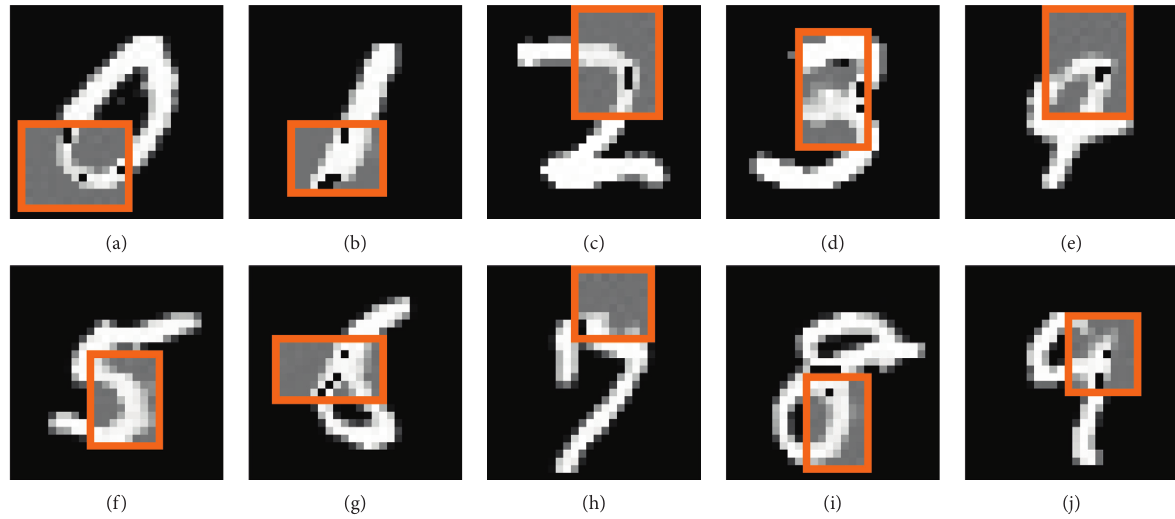
Figure 9: Prediction result by a base neural network on a training image with a label of (a) 0, (b) 1, (c) 2, (d) 3, (e) 4, (f) 5, (g) 6, (h) 7, (i) 8, and (j) 9 using randomly generated masks. The mask covers up a rectangular part of the image, and the predicted result is in the box.